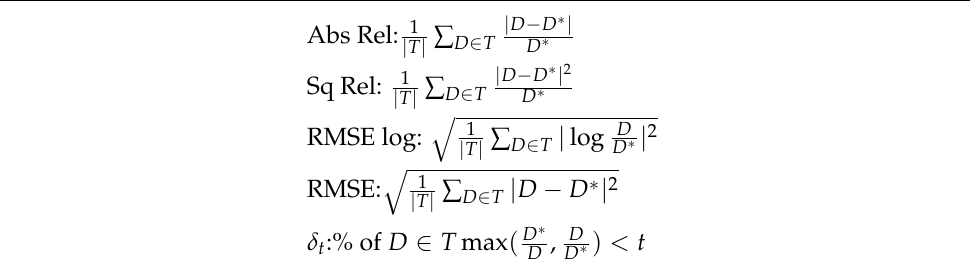
Table 1. Depth evaluation